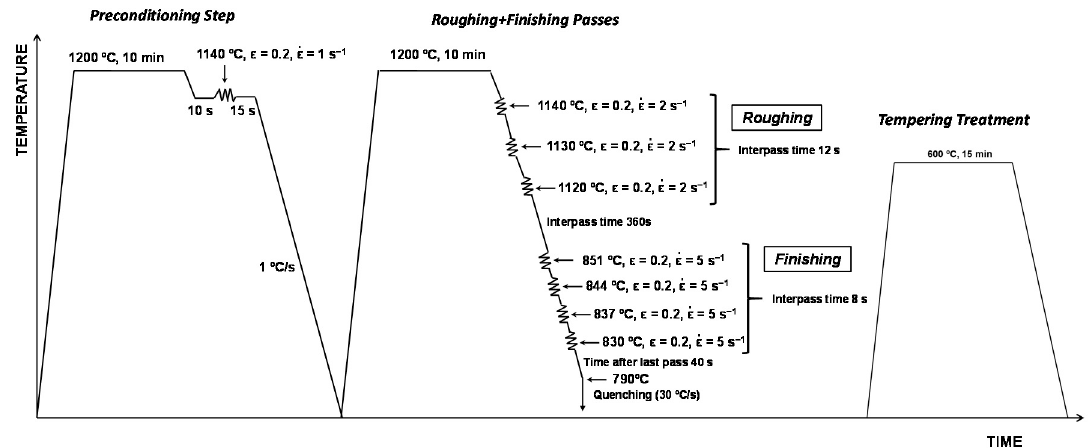
Figure 1. Schematics of the applied plane strain compression cycle.